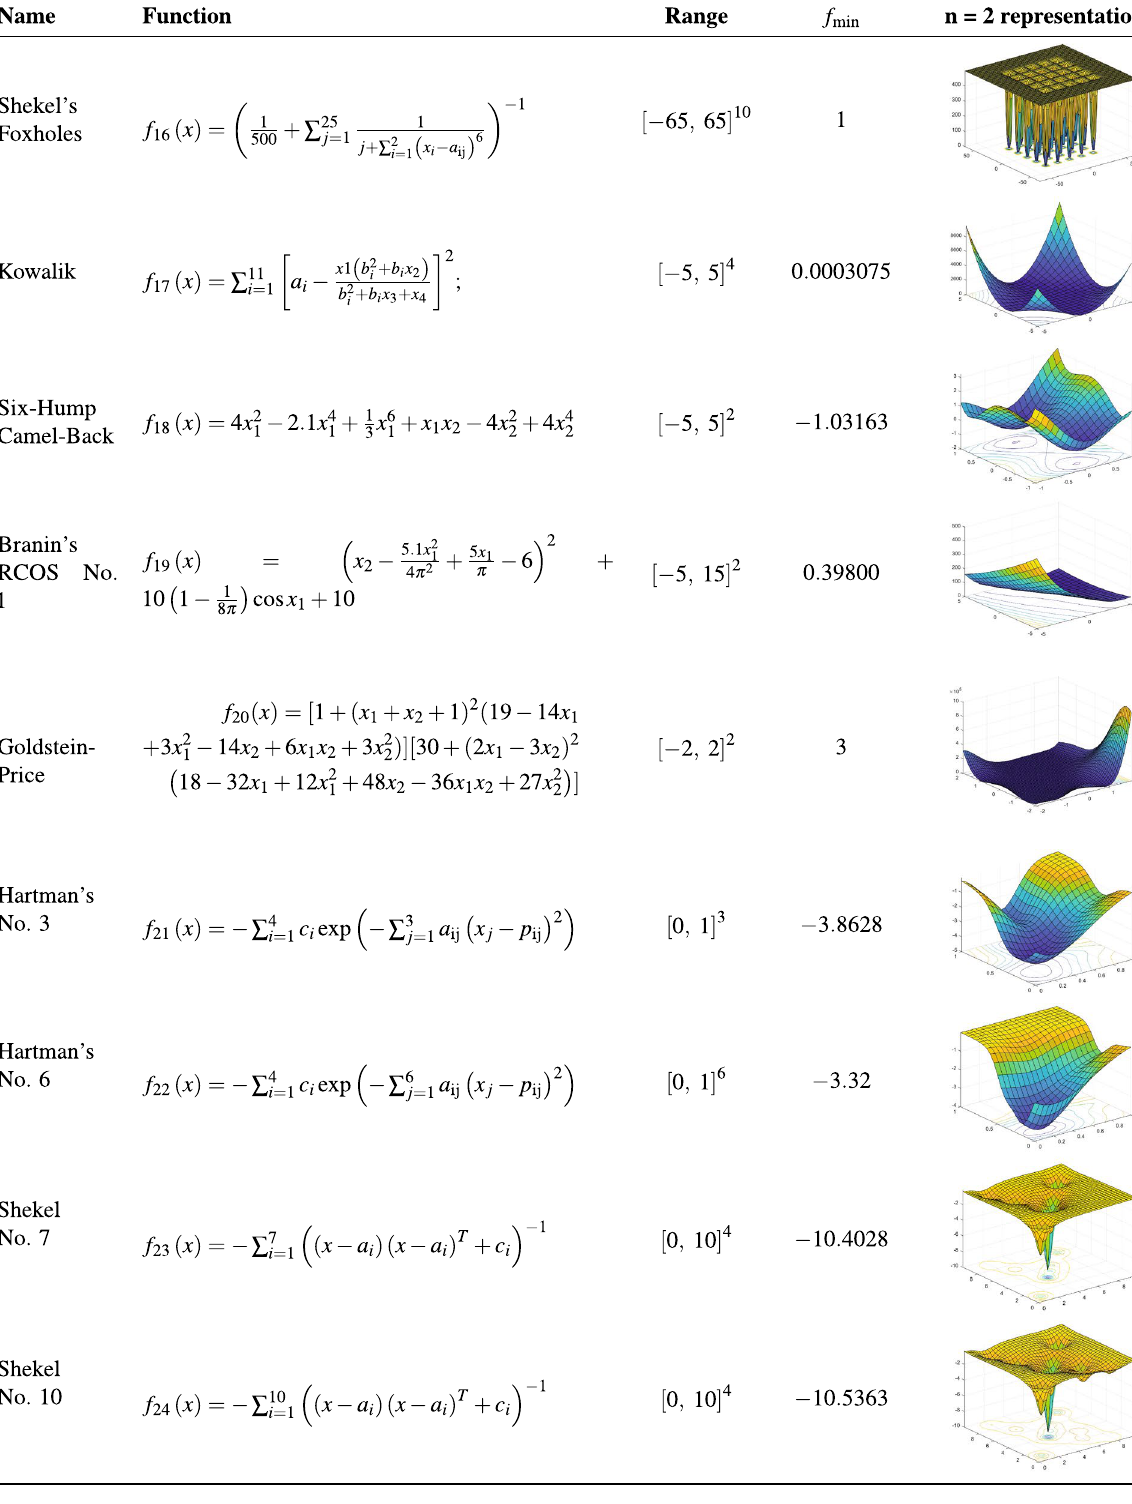
Table 9. Fixed-dimension multimodal benchmark